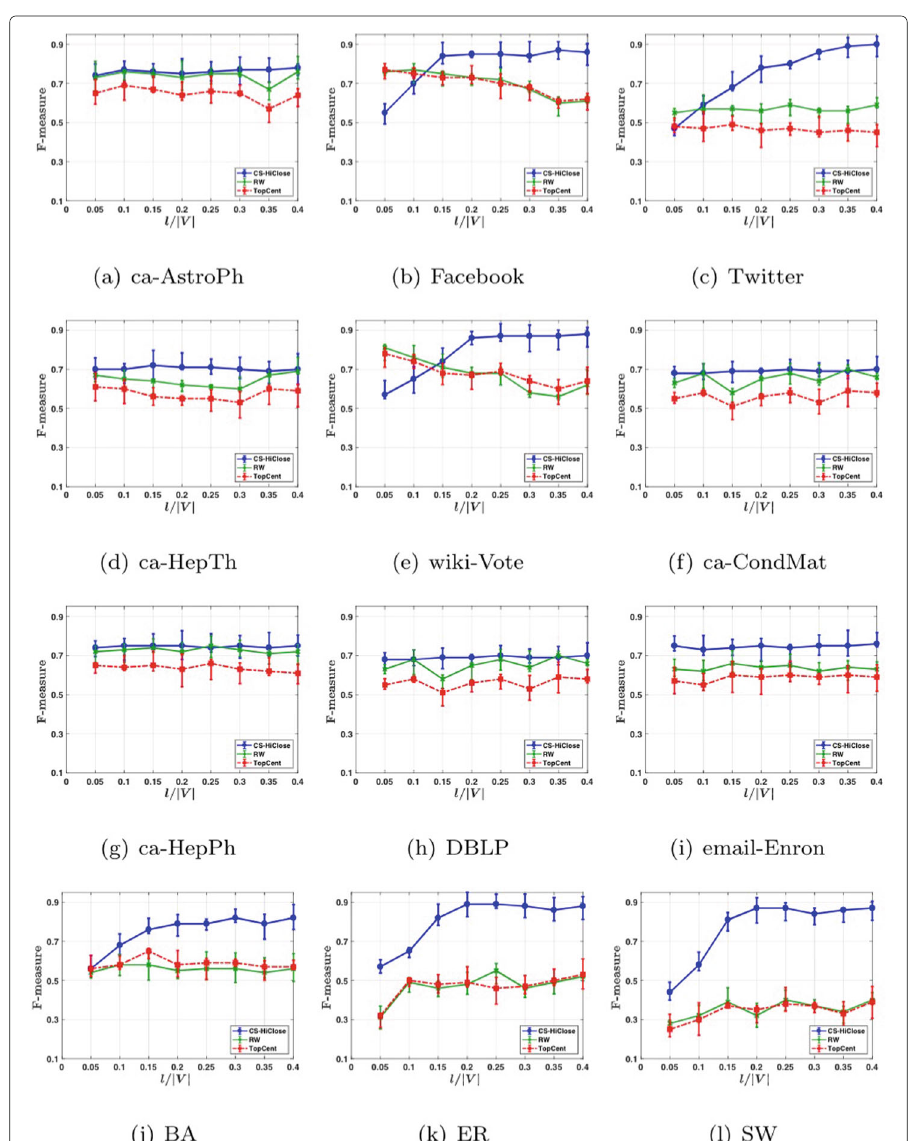
Fig. 5 Effect of measurement length l on the accuracy of CS-H I C LOSE in terms of F-measure, compared to RW, TopCent, and DICeNod. For each method, we set the number of measurements to 0.4 | V | and the sparsity level to 0.2 | V | in a network with | V |